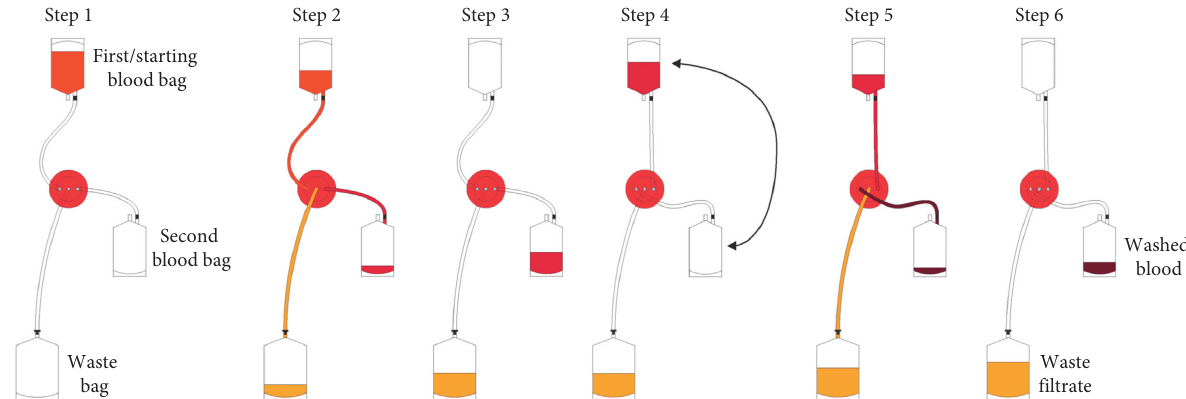
Figure 4: Schematic representation of the HemoClear filtration process. Step 1–3 represent first filtration round; steps 4–6 represent second filtration